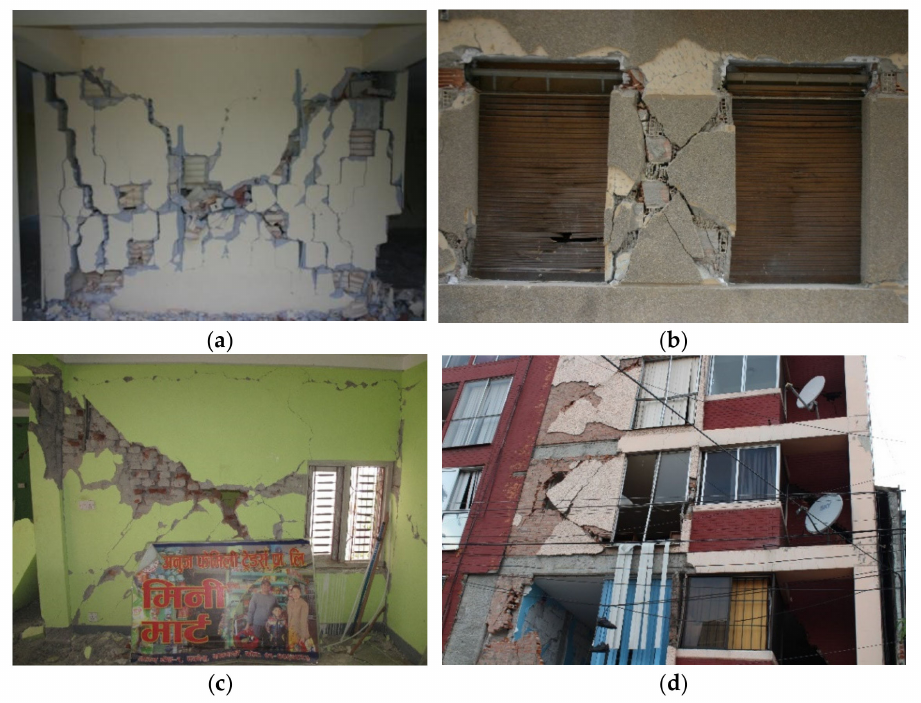
Figure 20. Damage type 10—damage in infill panels: diagonal cracking: ( a ) L’Aquila, Italy, 2009; ( b ) Lorca, Spain, 2011; ( c ) Gorkha, Nepal, 2015 and ( d ) Chiapas, Mexico,